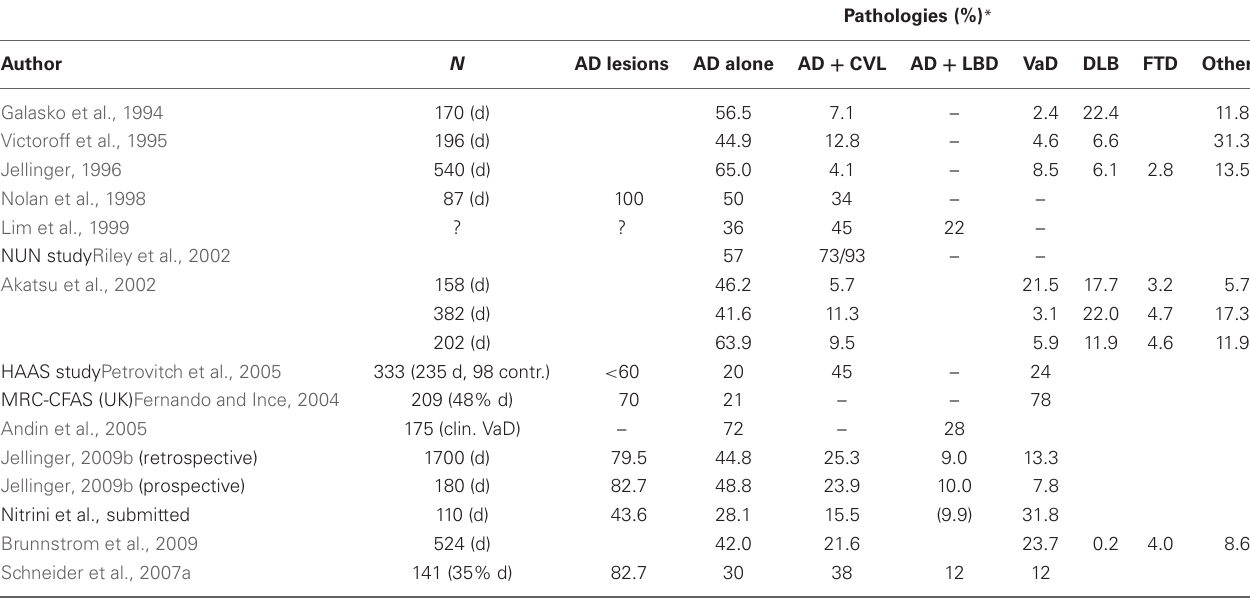
Table 4 | Frequency of mixed pathologies in autopsy series of elderly subjects.